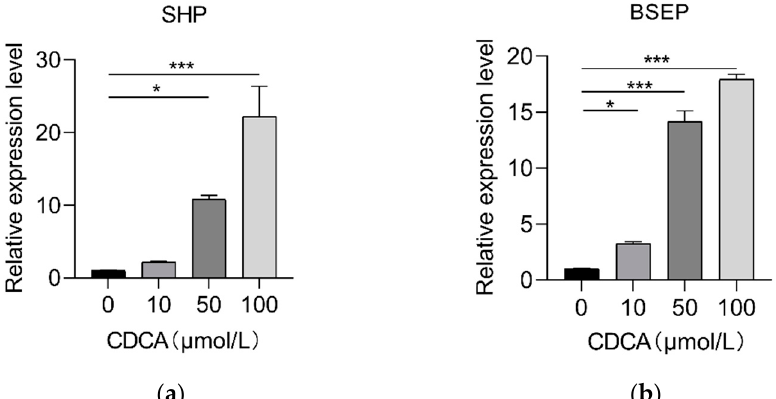
Figure 9. Relative expression of ( a ) SHP and ( b ) BSEP in pig primary hepatocytes with increasing doses of CDCA (0, 10, 50, and 100 μ mol/L), respectively. N = 3/group. Data are shown as means ± SE, * p < 0.05, *** p < 0.001.